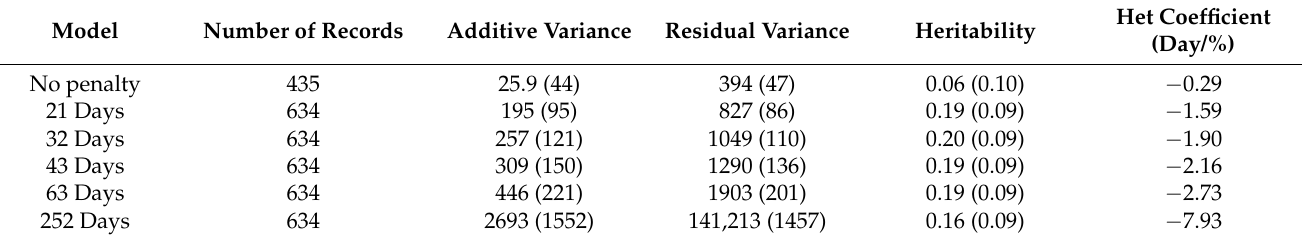
Table 5. Variance Components, heritability and heterozygosity (het) coefficient of DC1 with different penalty values with standard error in parenthesis.